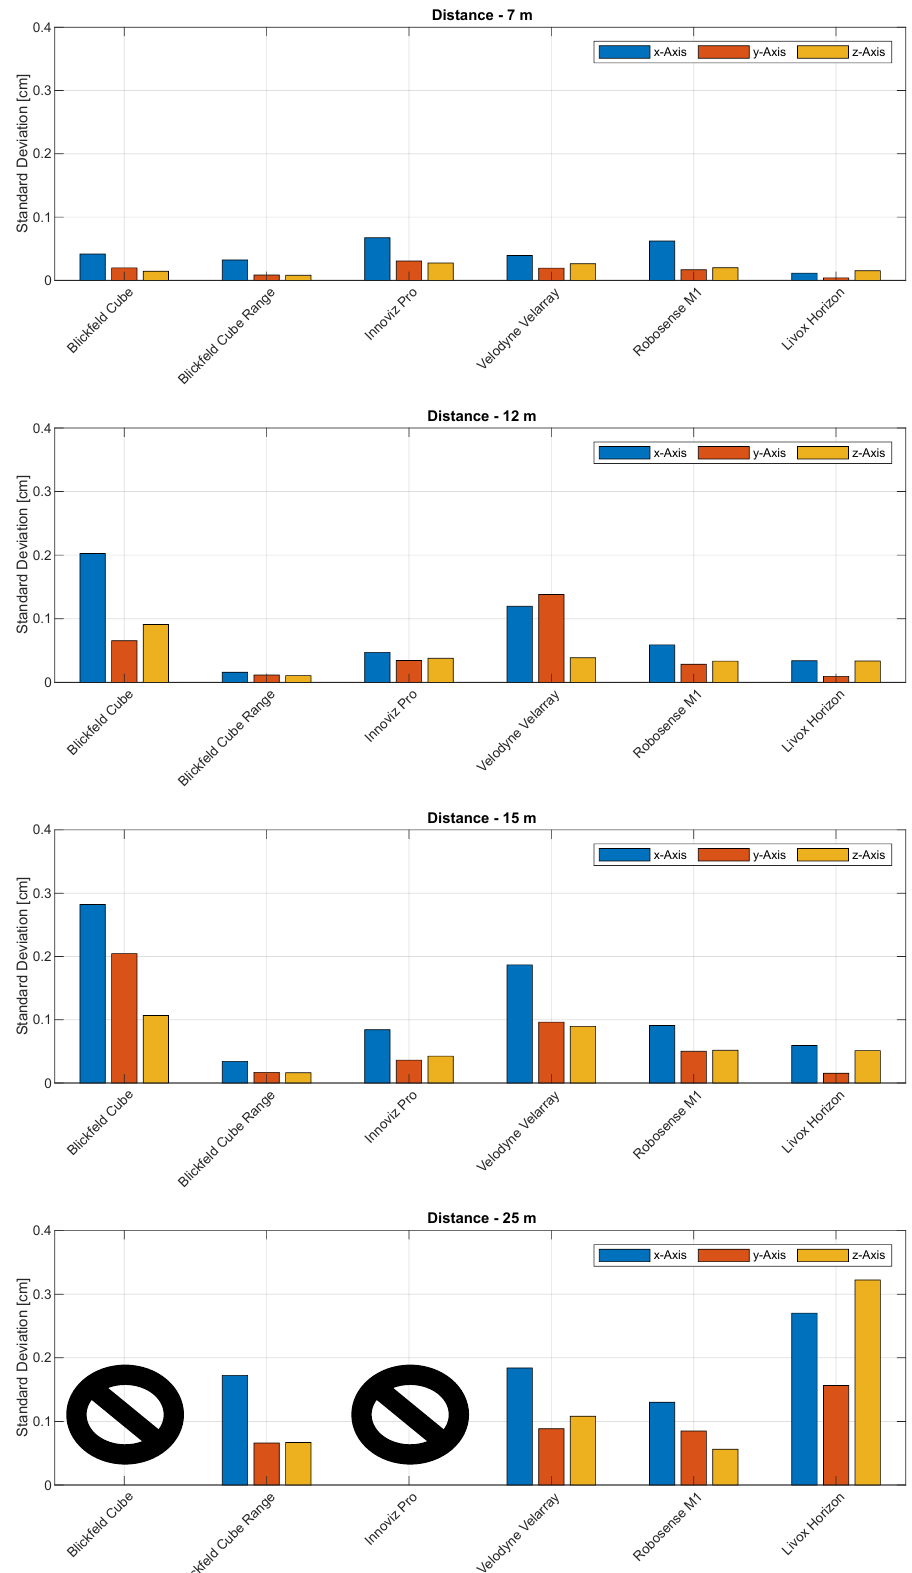
Figure 6. Results: Standard deviations for each individual axis in scenario ’Static Spheres Increasing Distances’ at 7 m, 12 m, 15 m and 25 m; normal distribution with 1000